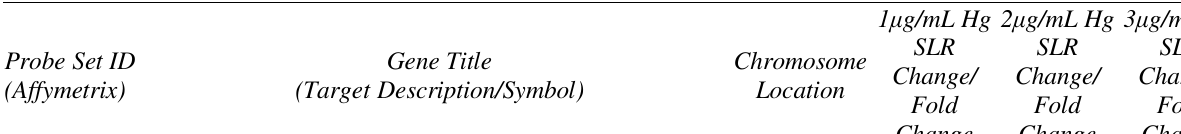
Table 1 contd.: Sample genes affected by mercury.